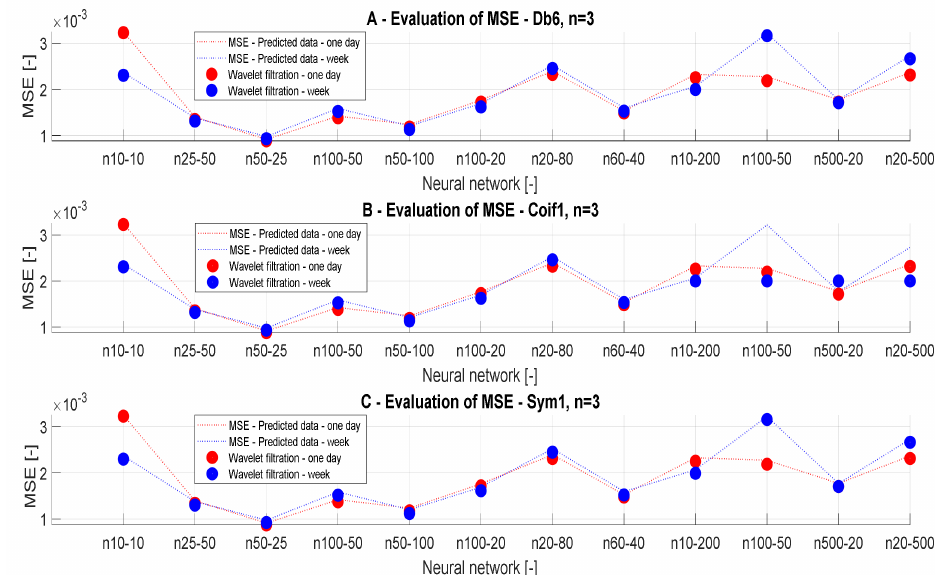
Figure 17. Trend characteristics for MSE values, a comparison of the reference signals with the wavelet-based filtration for di ff erent neural network settings and time prediction.